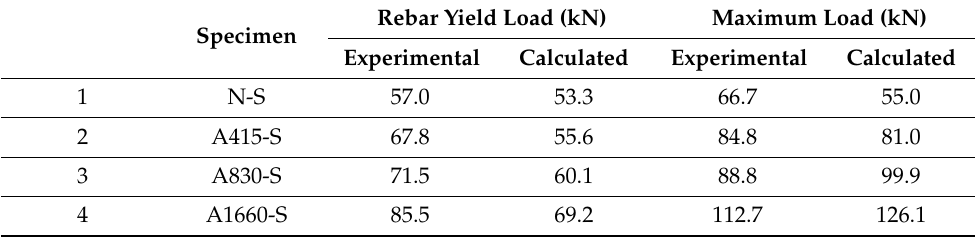
Table 5. Calculated and experimental results of the beams in the static tests.